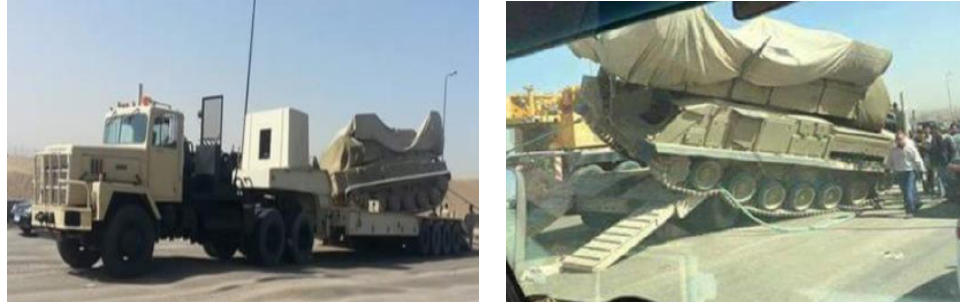
Figure 1. Accidents due to tank loads eccentricity.